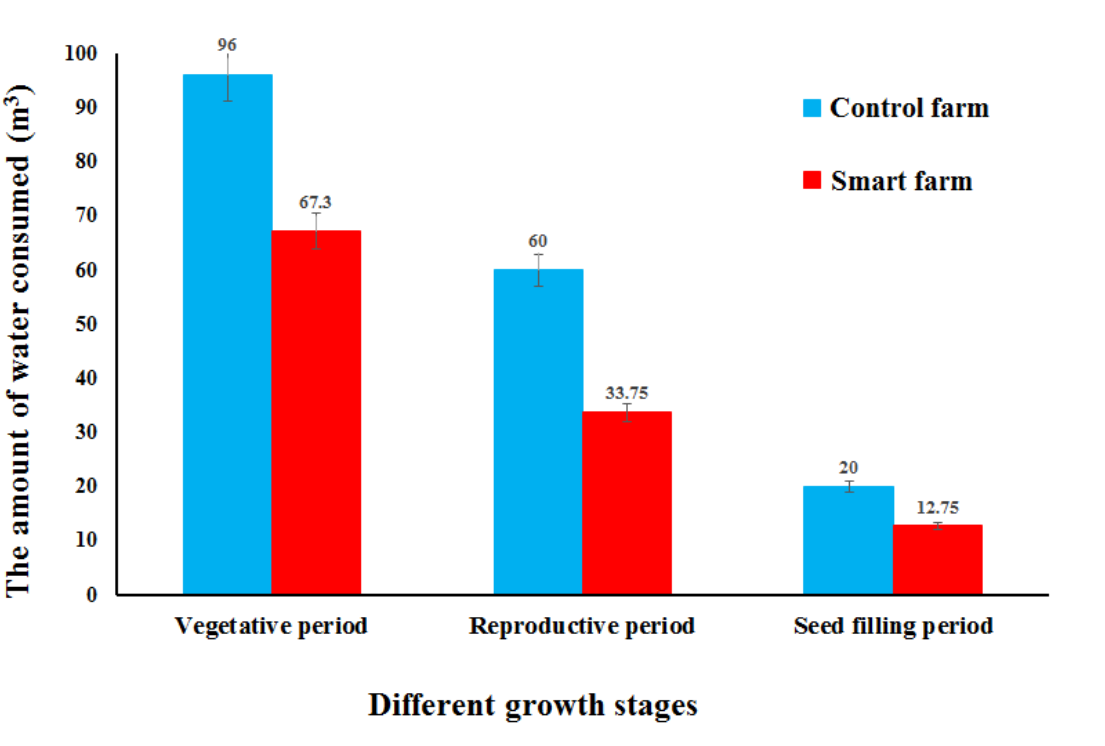
Figure 6. The final condition of the pilot and control farm irrigation hours.